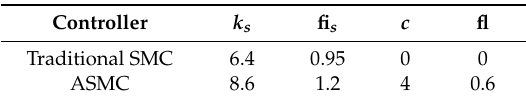
Table 4. The parameters of the sliding mode control based on adaptive reaching law (ASMC) and traditional sliding mode control (SMC).